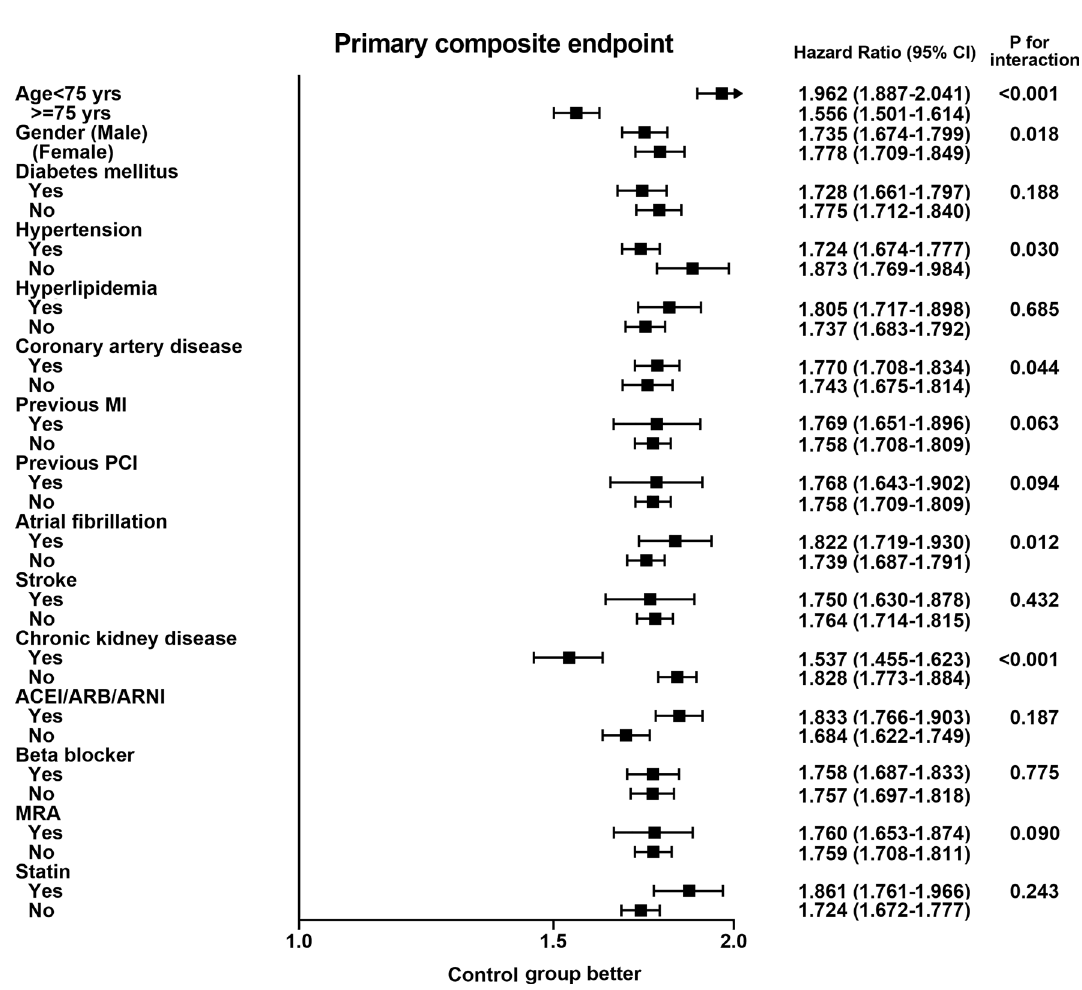
Figure 3. Forest plot of subgroup analysis. Subgroup analysis showed the risk was consistently higher in the infection group than the controls in all subgroups. P for interaction test showed the impact of infection may vary by age, gender, and in patients with a history of hypertension, atrial fibrillation, and chronic kidney disease. MI myocardial infarction, PCI percutaneous coronary intervention, ACEI